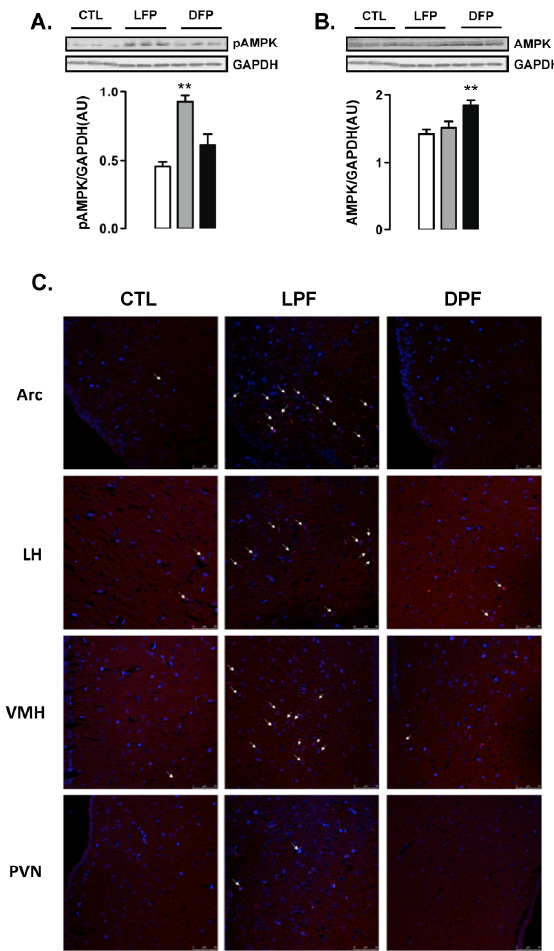
Figure 2. AMPK phosphorylation and content in hypothalamus of rats exposed to fructose consumption during the light or the dark phases. Rats assigned to the groups control (CTL), Light Phase Fructose (LPF) and Dark Phase Fructose (DPF) had their hypothalamus removed at the end of the eighth week of treatment. A first set of samples was used for ( A ) Western blot detection of phosphorylated Adenosine Monophosphate ‐ activated protein kinase (AMPK) and ( B ) total AMPK. Target proteins were normalized to Glyceraldehyde 3 ‐ phosphate dehydrogenase (GAPDH). A second set of samples was processed for immunofluorescent staining. Sections were stained using an anti ‐ pAMPK antibody followed by secondary antibody conjugated to Alexafluor 546 (red). Nuclear structures are visualized by 4 ′ ,6 ‐ diamidino ‐ 2 ‐ phenylindole (DAPI) probing (Blue). ( C ) Large magnification (400×) images are shown from the arcuate nucleus (ARC), lateral hypothalamus (LH), ventro medial hypothalamus (VMH) and paraventricular nucleus (PVN). The results are presented as the means ± standard error of the mean. ** p < 0.05 vs. CTL.